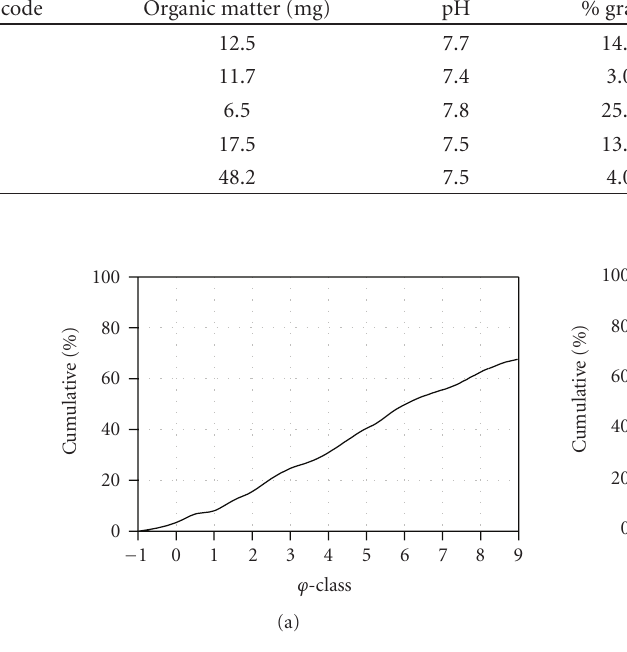
Table 4: Physical-chemical and granulometry characteristics of the soils sampled in 2008 at nesting sites of L. malachurum . Sample code